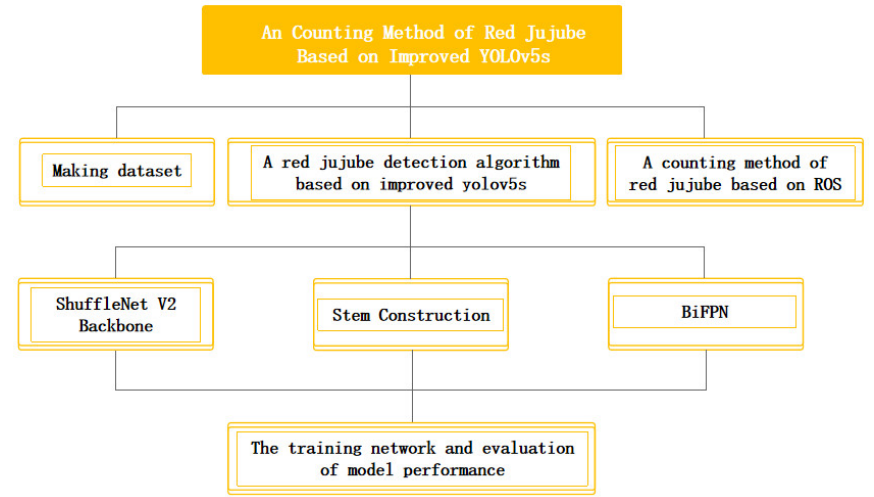
Figure 1. A counting method of red jujube based on improved YOLOv5s.